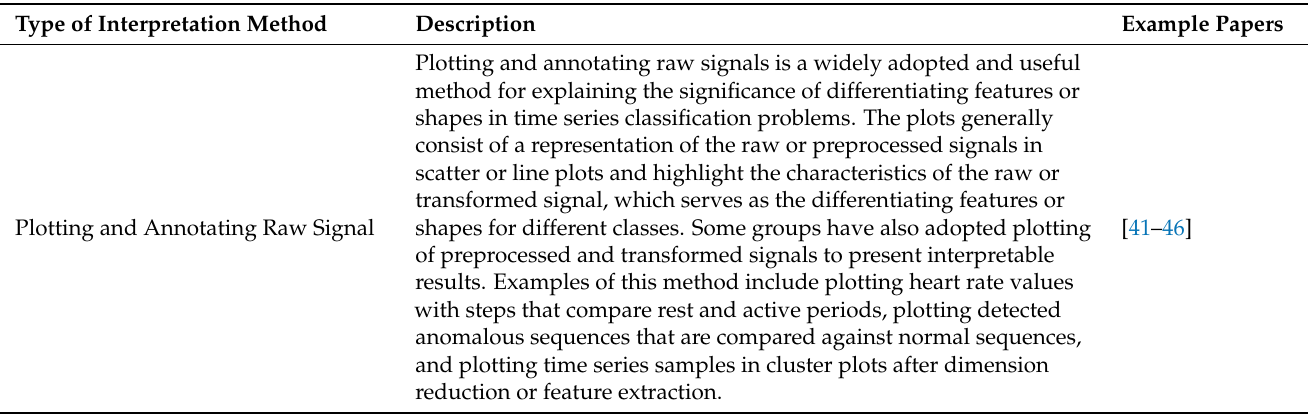
Table 2. Summary of the different types of model interpretation methods discussed or used in each